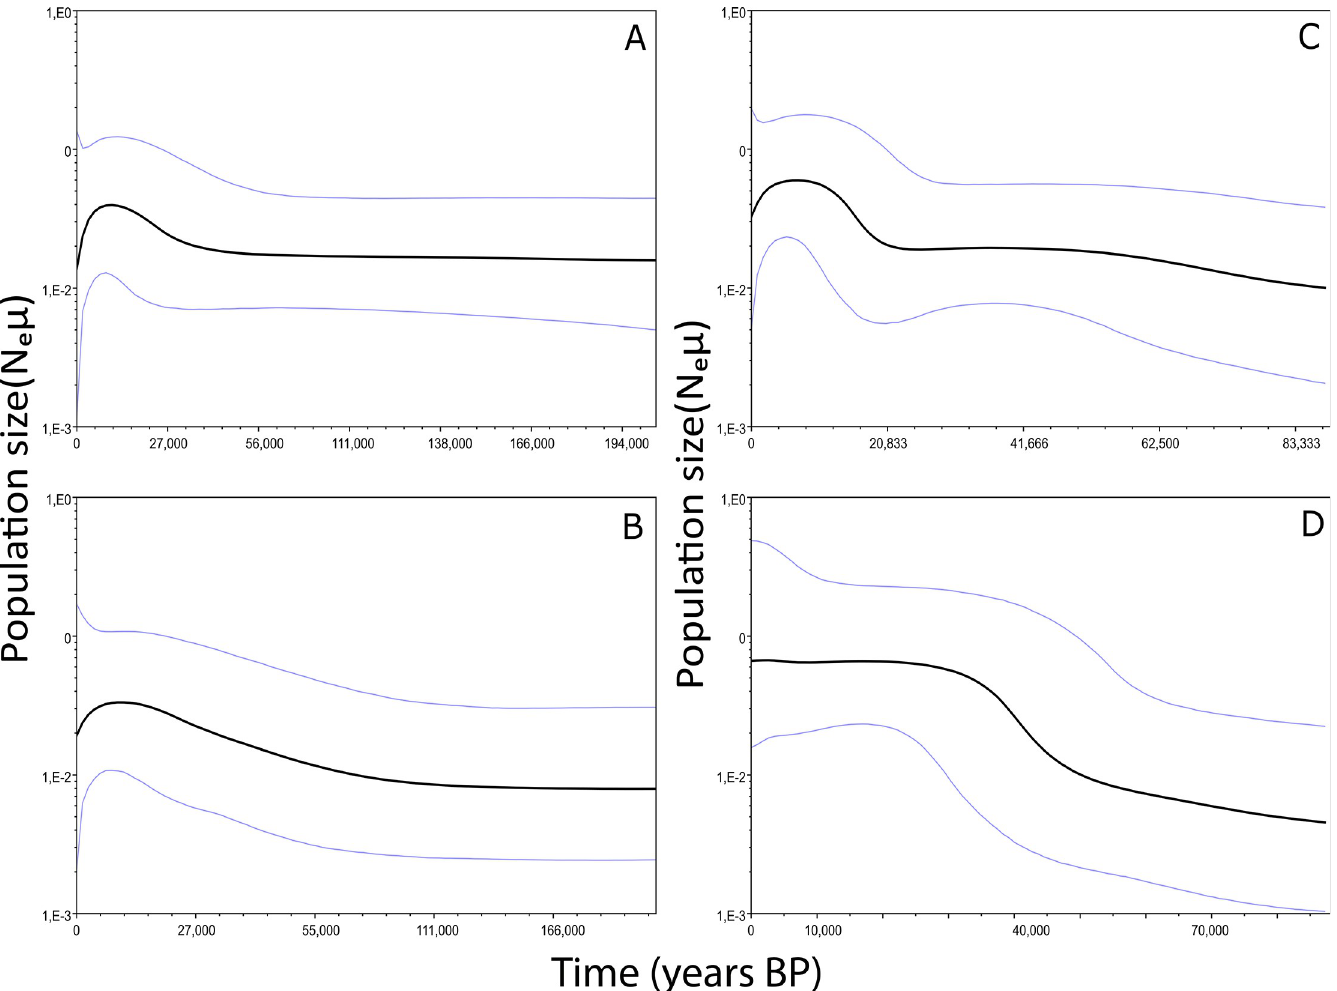
Fig 5. Bayesian Skyline Plots showing the demographic evolution for the P . guyannensis , G1 (A) and G2 (B) and P . cuvieri C2 (C) and C3